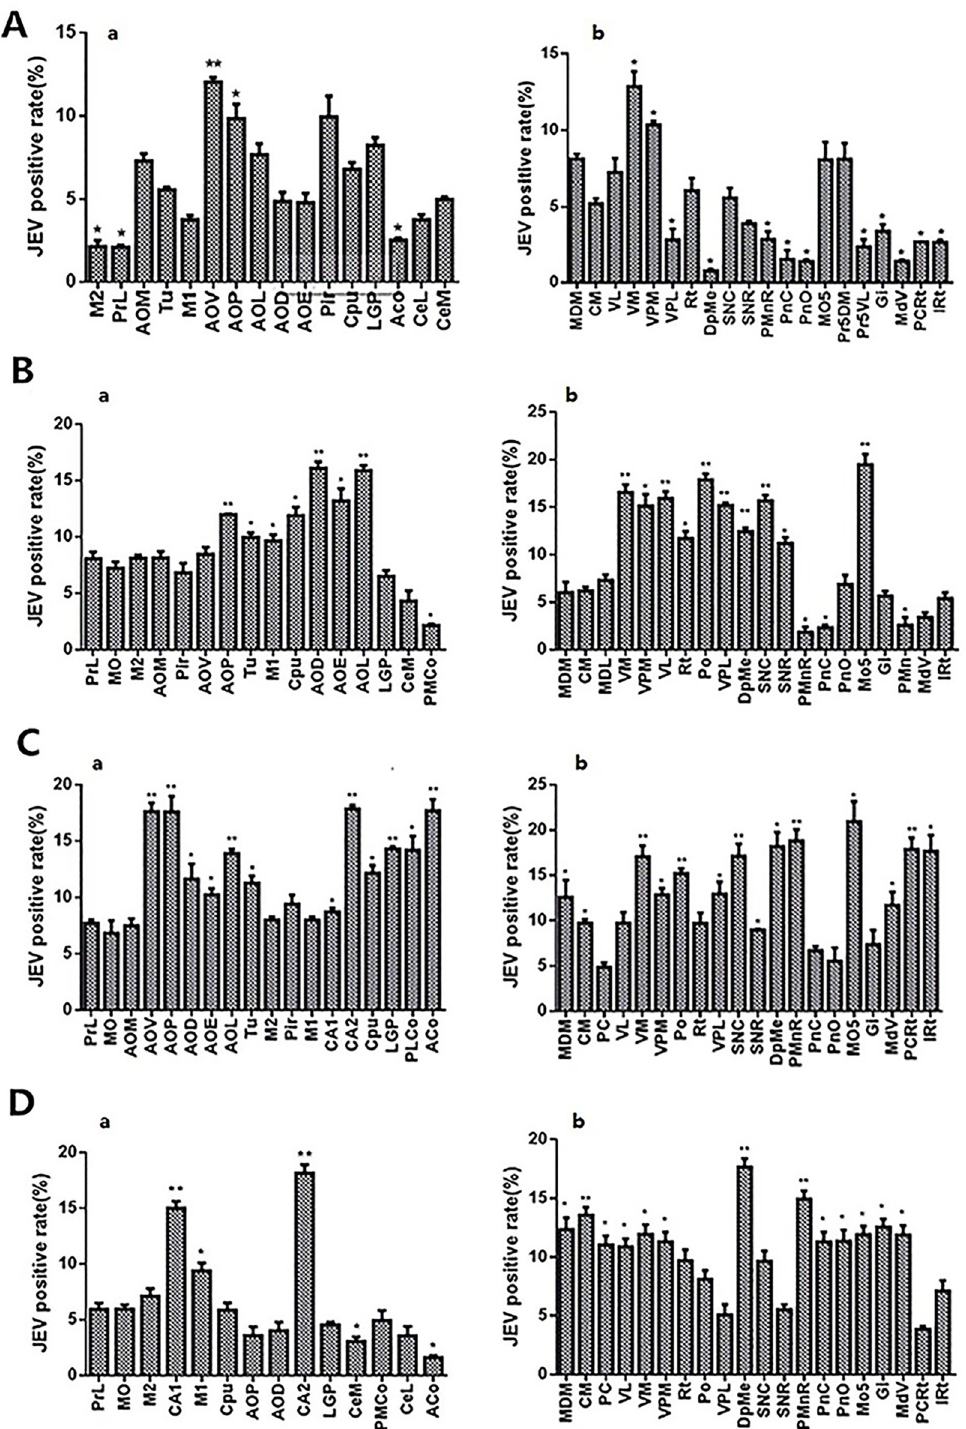
Fig 4. Statistical changes in the expression of virus in major cranial nerve nuclei at different times in JEV infected mice. (A-D) represents 4 dpi, 5 dpi, 6 dpi, and 8 dpi, We calculated the positive rate of JEV in the nerve nucleus in each period after infection, and compared it with the positive rate of JEV in Rt on the 3 rd day after infection to show the degree of JEV infection in different periods. (a) the positive rate of JEV in the major cranial nerve nuclei, (b) the positive rate of JEV in the nuclei of diencephalon and brainstem. � P < 0.05, �� P < 0.01, n = 3.